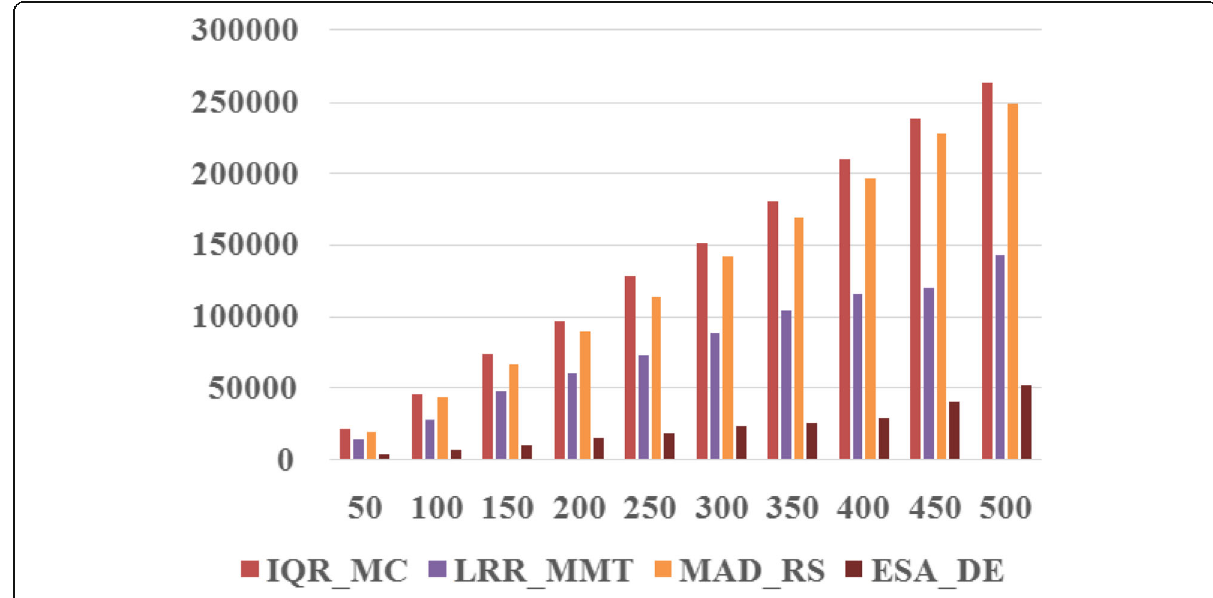
Fig. 6 Total migration cost of the virtual machine under different task numbers